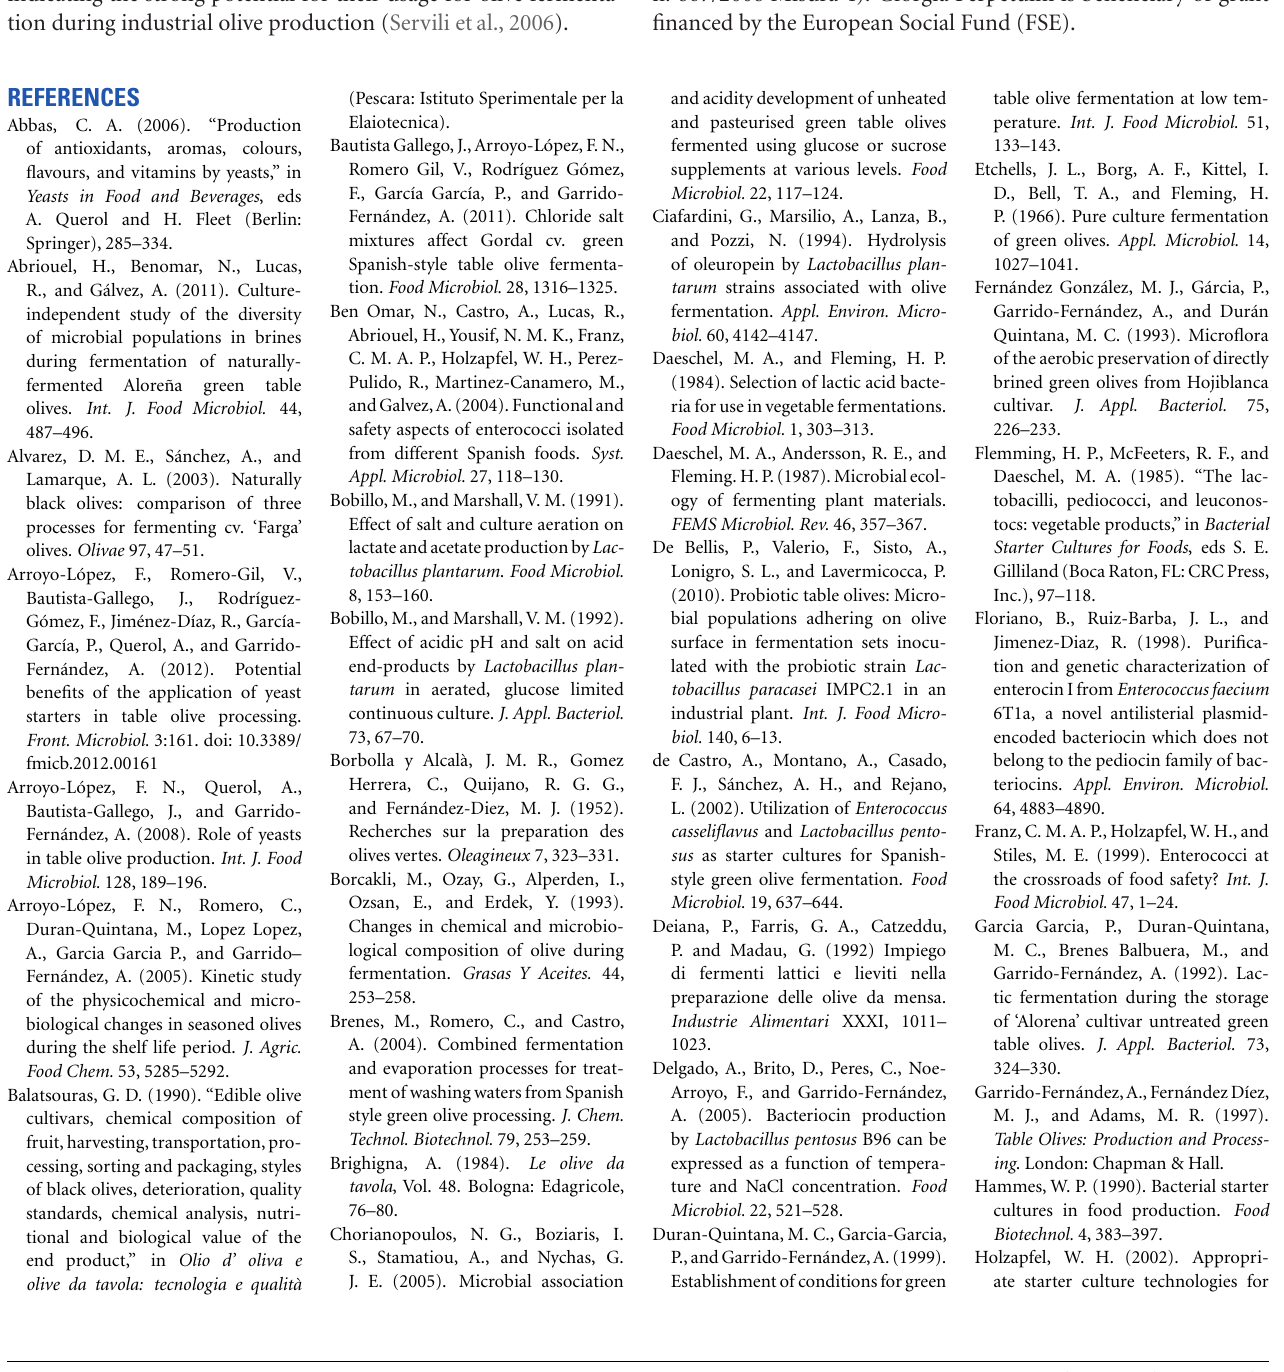
Table Olives: Production and Process- ing . London: Chapman &